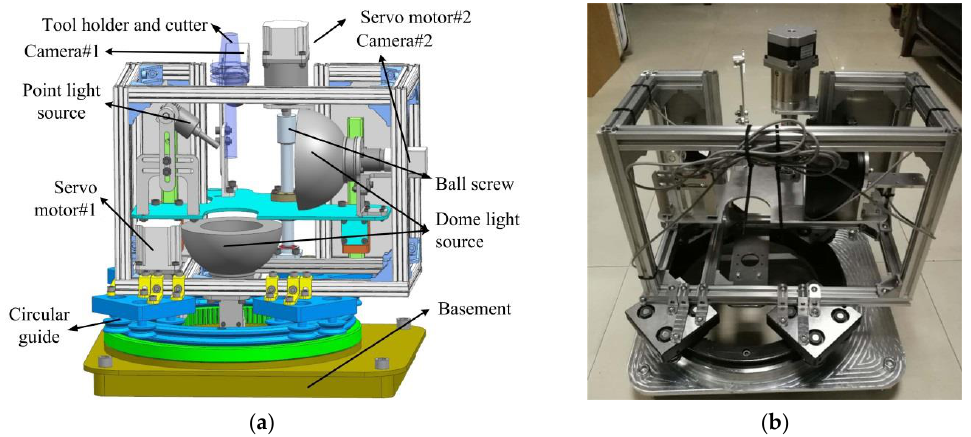
Figure 3. The proposed image acquisition system: ( a ) Structure components; ( b ) Assembled system.